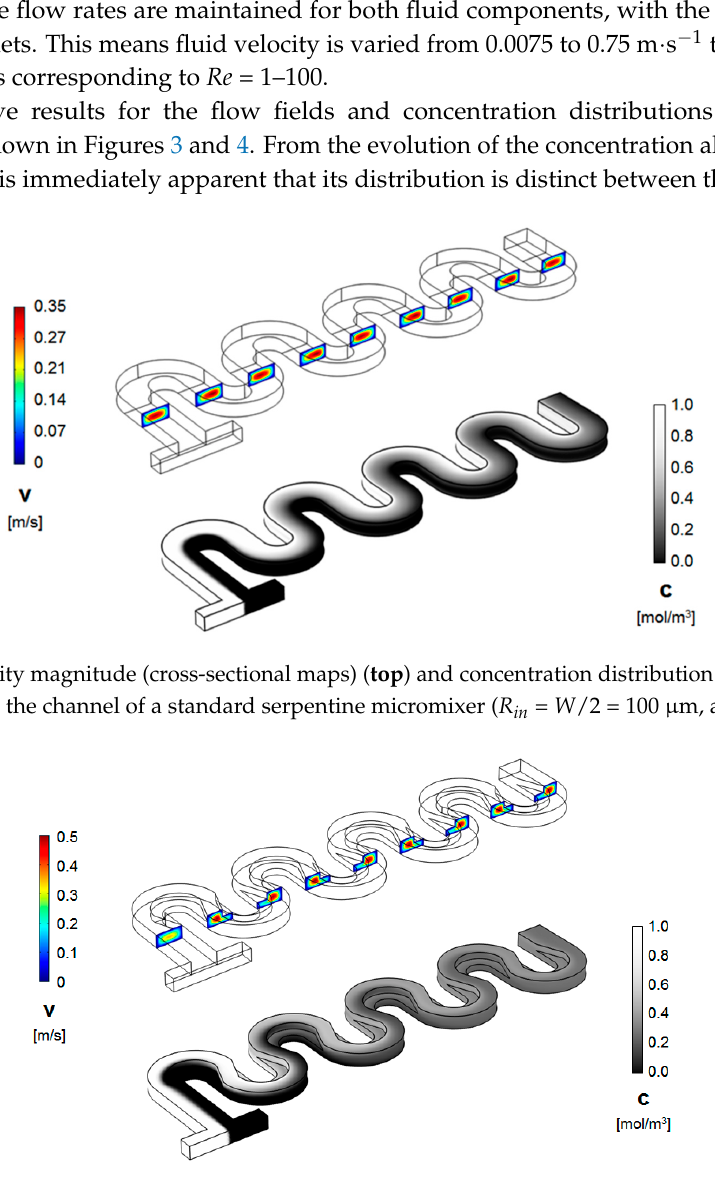
Figure 4. Velocity magnitude (cross-sectional maps) ( top ) and concentration distribution (surface map) ( bottom ) along the channel of a non-rectangular cross-section serpentine micromixer ( R in = W/2 = 100 μ m, and Re = 20).